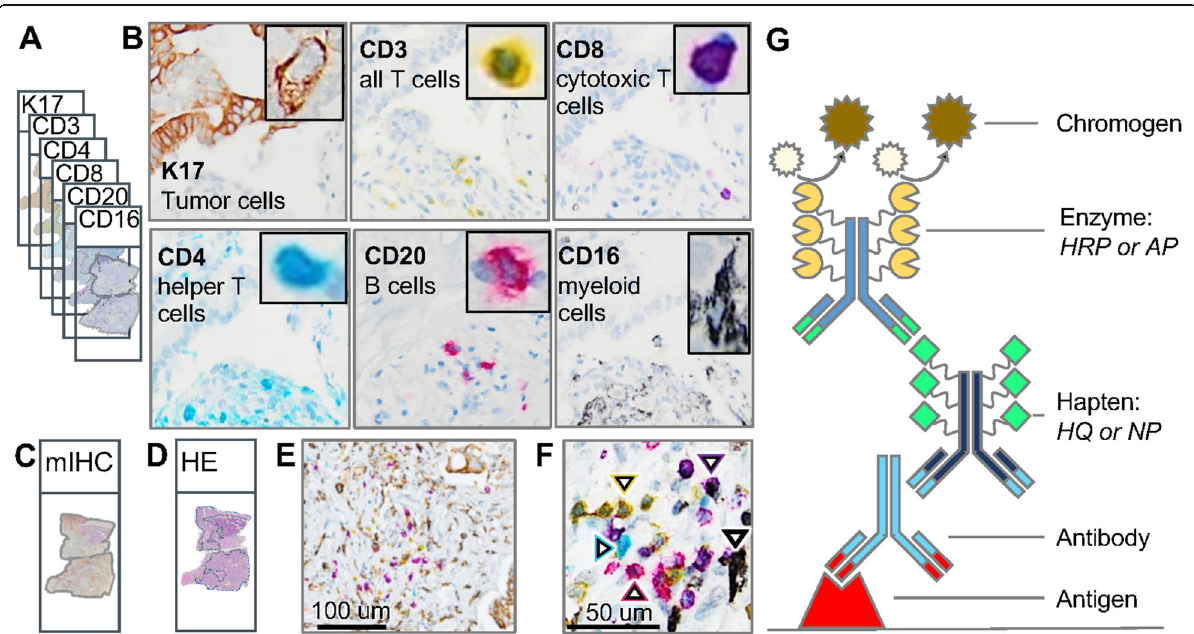
Fig. 1 IHC markers in the PDAC mIHC panel to study tumor immune interactions. a Traditional IHC to stain six adjacent serial tissue sections with one biomarker per tissue section. Each biomarker is designated by a specific color. b Representative images from one marker IHC in serial tissue sections showing expression in the same region of interest (except for examples of sparsely distributed B-cells from a different area in the corresponding histologic section). Each inset shows the cellular expression of the corresponding marker at higher magnification. C. Multiplex IHC (mIHC) in adjacent serial section. d Hematoxylin and eosin (H&E) in adjacent serial sections with delineation of the tumor region by a pathologist. e mIHC with six IHC markers on a single tissue section with PDAC. f At the highest magnification, each of the five immune cell classes are labeled with a white arrowhead outlined in the color corresponding to chromophore color. T-cell subtypes include CD3+ (yellow), CD4+ (teal), CD8+ (purple); B-cells denoted by CD20+ (red); and myeloid cells identified by CD16+ (silver-black). g Indirect mIHC using hapten-conjugated secondary antibodies. Primary antibody binds to target antigen; secondary anti-mouse or anti-rabbit IgG antibody conjugated to synthetic haptens (HQ or NP) to bind primary antibody; and anti-hapten tertiary antibody conjugated to multiple enzyme molecules (e.g. horseradish peroxidase (HRP) or alkaline phosphatase (AP)) to bind secondary antibody. Chromogen substrate reacts with enzymes to generate insoluble unique color signal at the site of the targeted